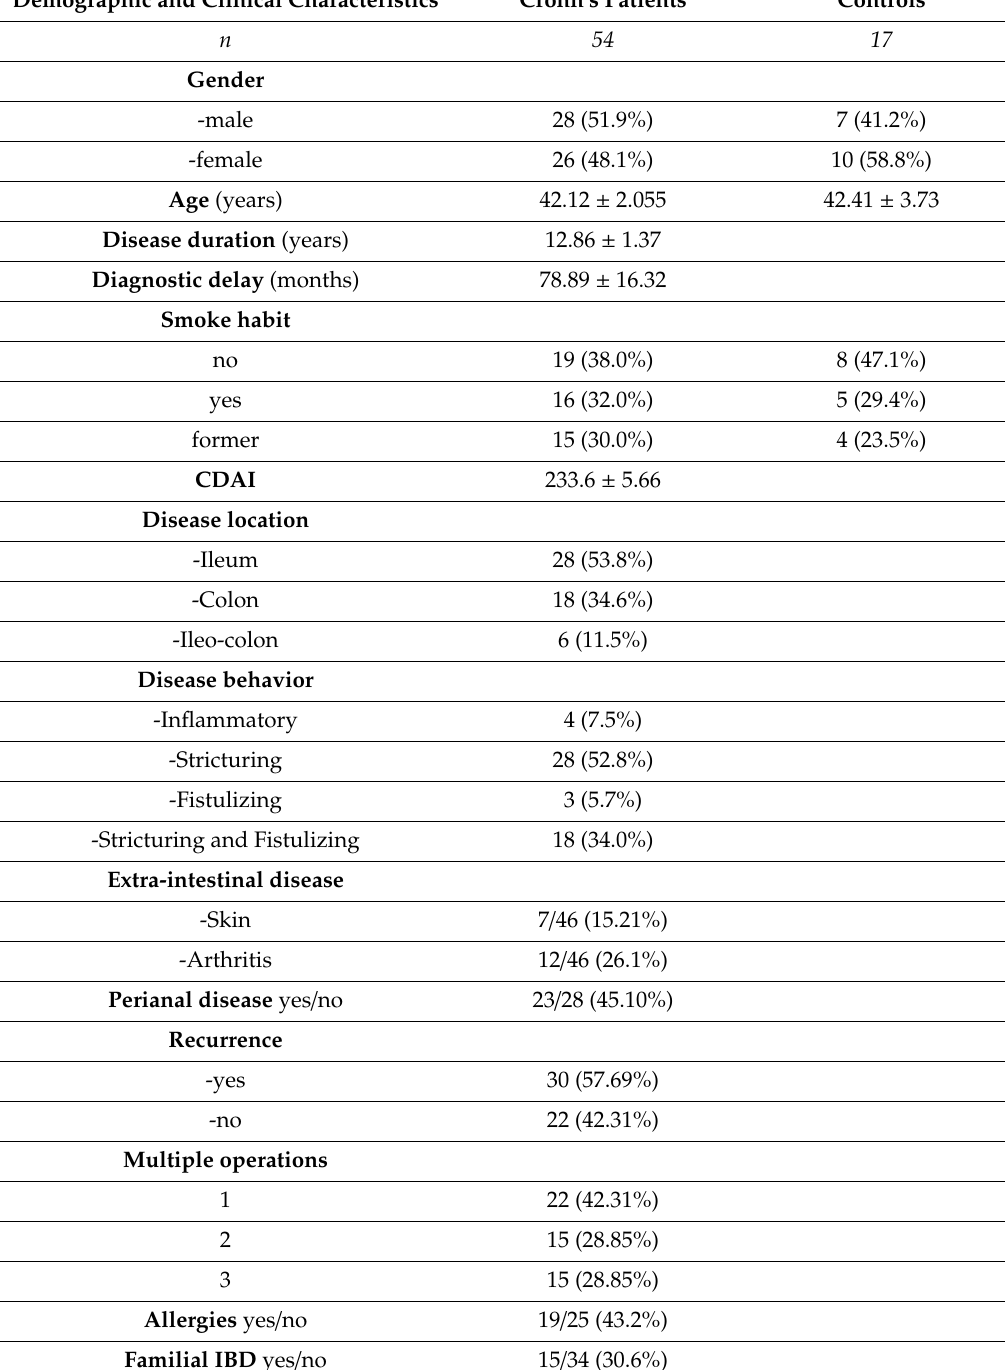
Table 1. Demographic and clinical characteristics of Crohn’s patients and healthy volunteers enrolled in the